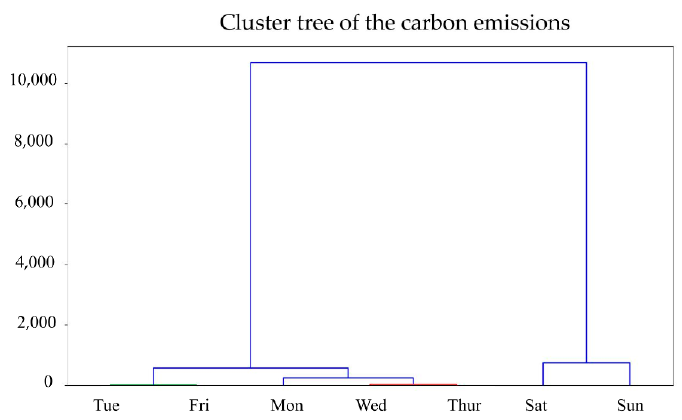
Figure 4. Cluster tree of the carbon emissions for the buses in Sanya.